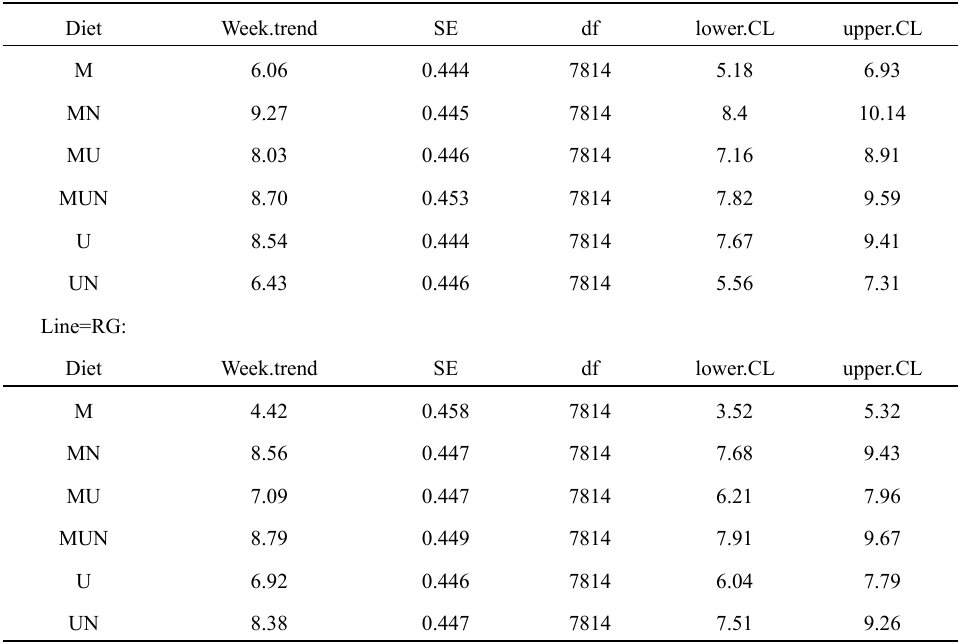
Table S1. – Results from the slope analysis of the relative growth rate performed with the emtrends function from the emmeans R